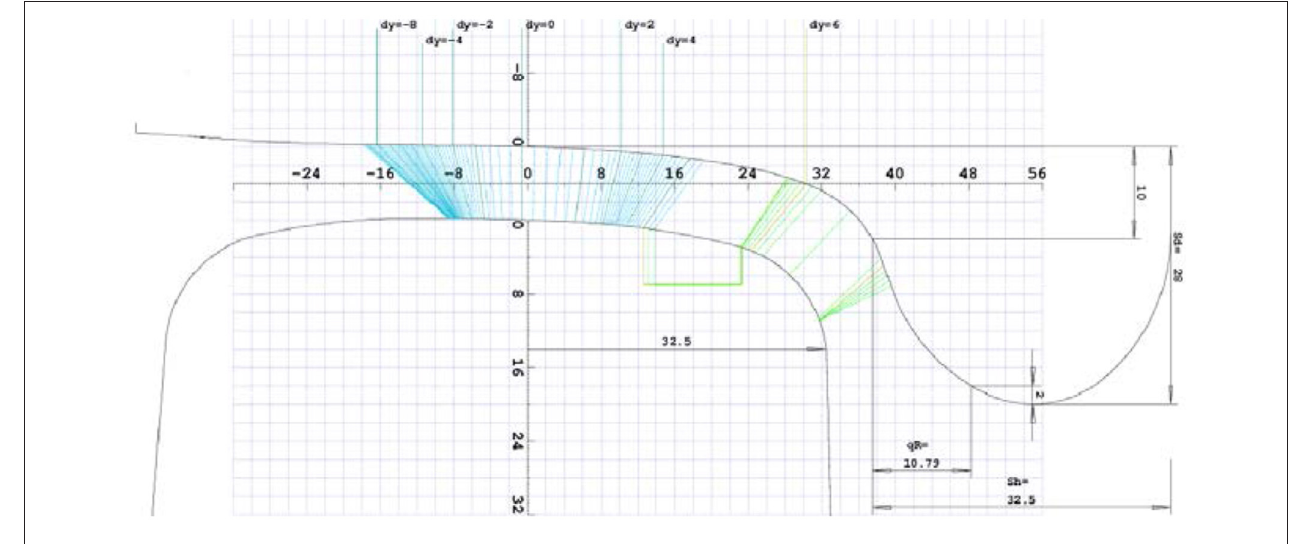
FIGURE 4 | Wheel and rail contact.